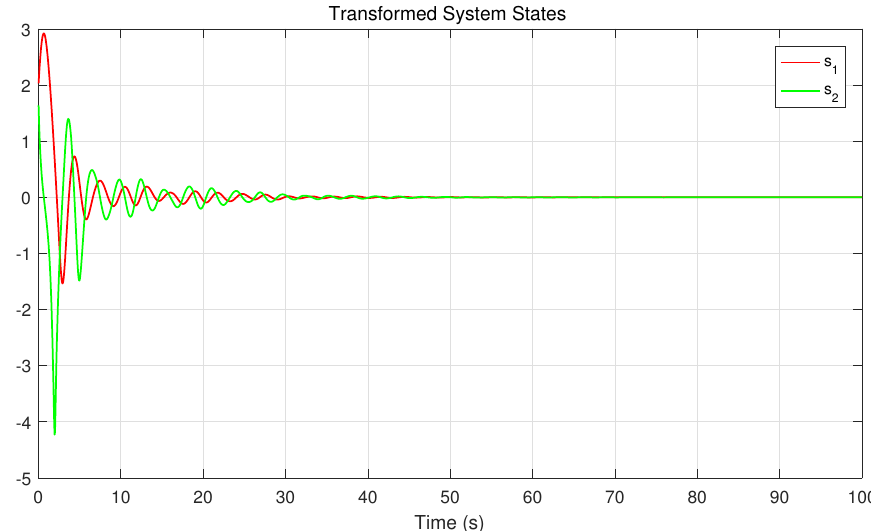
Figure 10. Transformed system states using the presented